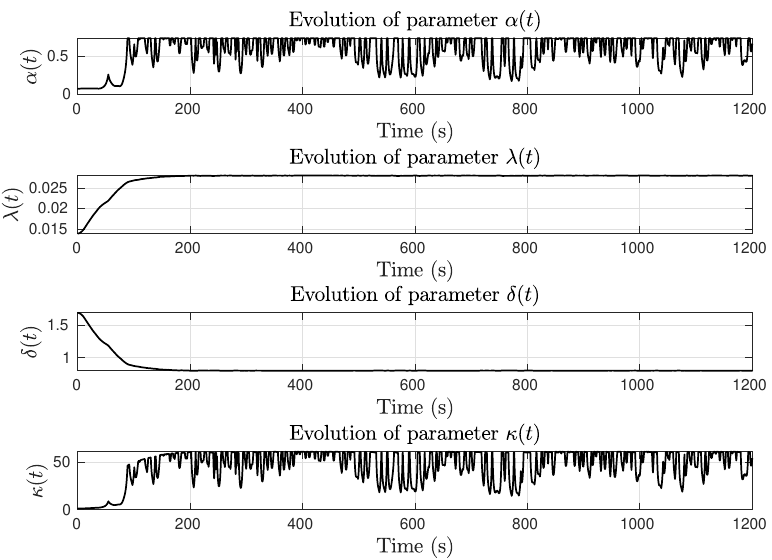
Figure 8. Constant yaw reference test with d ( t ) (cid:54) = 0. Adaptive parameters